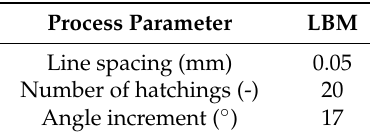
Table 5. Hatching parameter values for